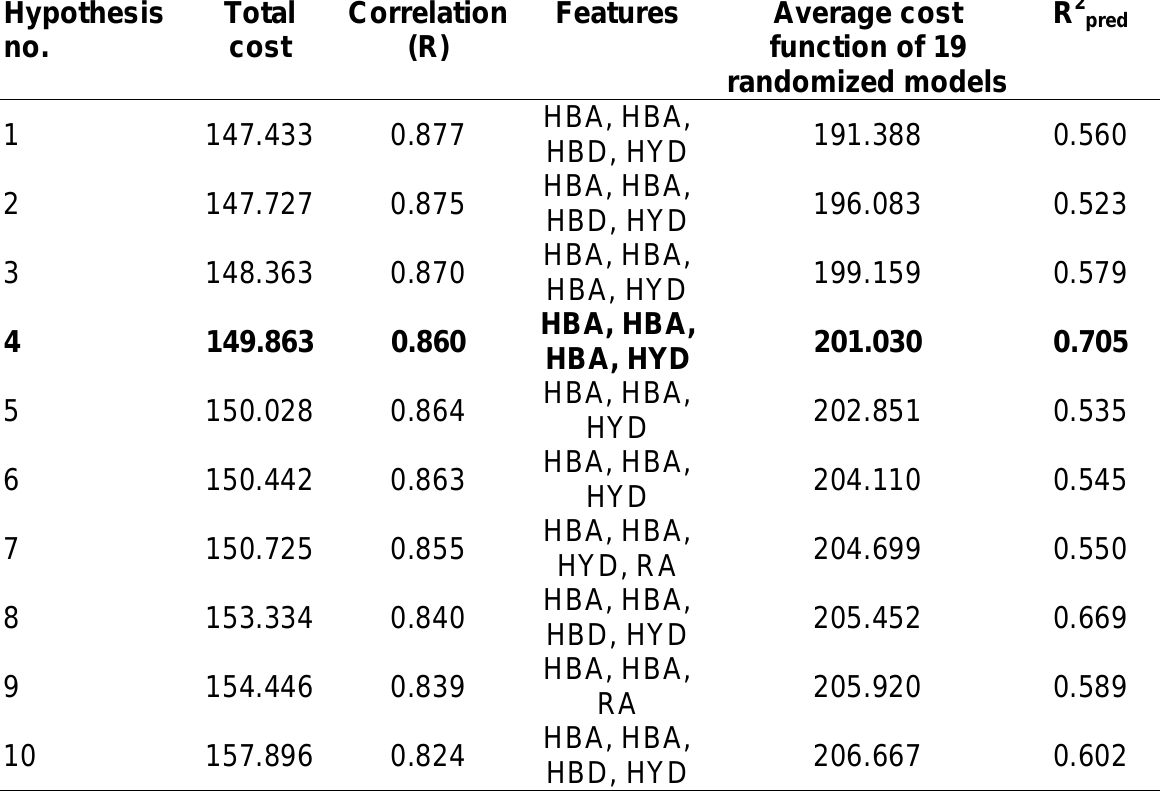
Results obtained from the Pharmacophore Hypotheses using the BEST